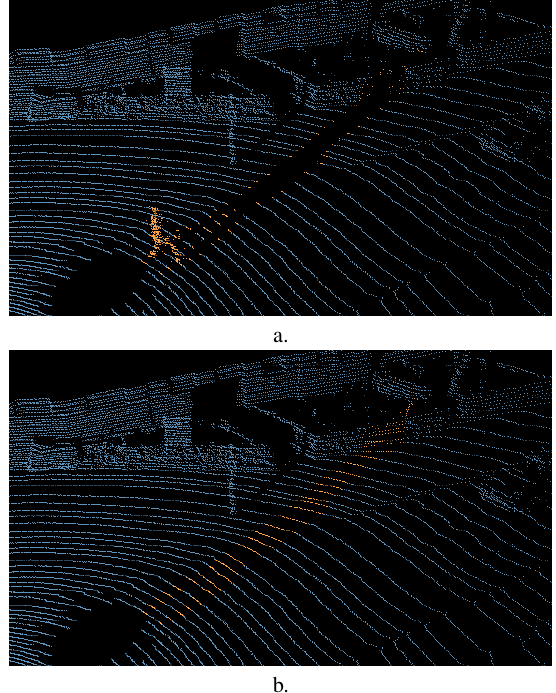
Figure 9. Result of the disocclusion on a pedestrian in 3D. (a) is the original mask highlighted in 3D, (b) is the final